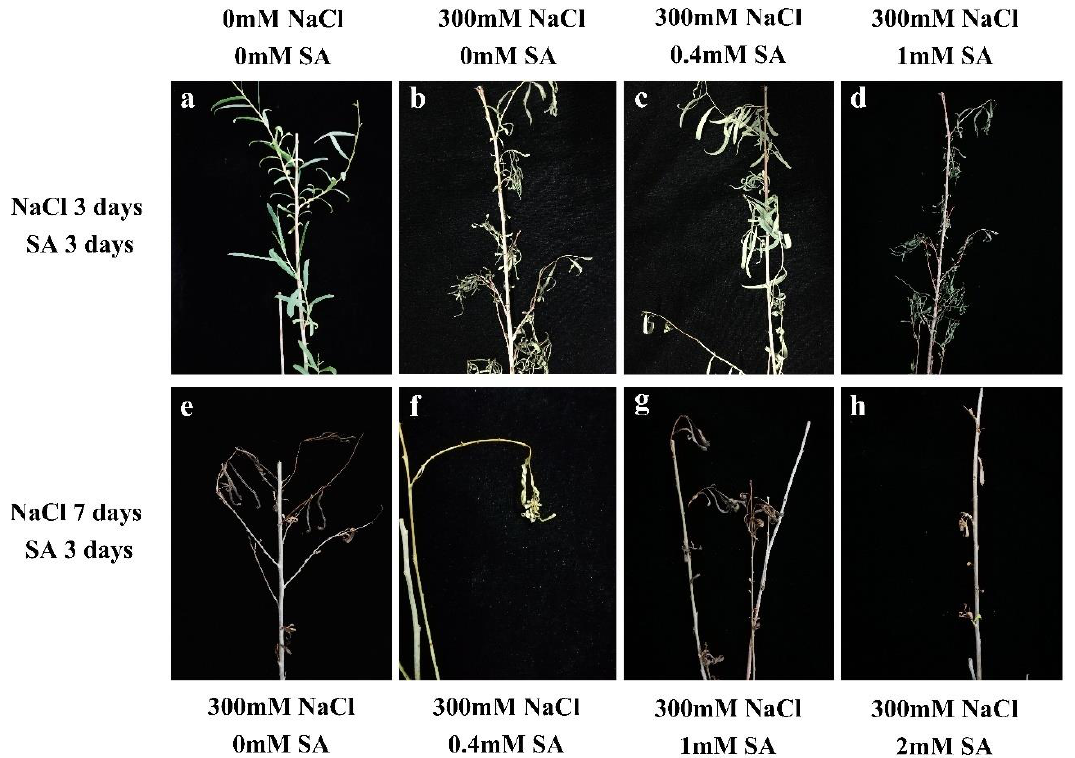
Figure 2. Phenotypes of P. euphratica seedlings treated with SA and salt stress. ( a ) Seedling grown under normal condition. ( b ) Seedling only treated with 300 mM NaCl for 3 d. ( c ) Seedling treated with 0.4 mM SA (3 d) + 300 mM NaCl (3 d). ( d ) Seedling treated with 1 mM SA (3 d) + 300 mM NaCl (3 d). ( e ) Seedling only treated with 300 mM NaCl for 7 d. ( f ) Seedling treated with 0.4 mM SA (3 d) +